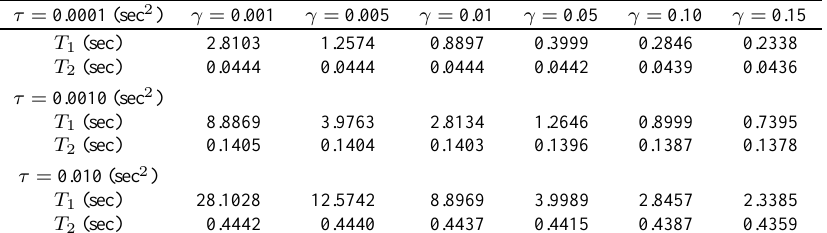
Table 1 First and second natural periods of vibration (i.e. T 1 and T 2 ) versus τ and